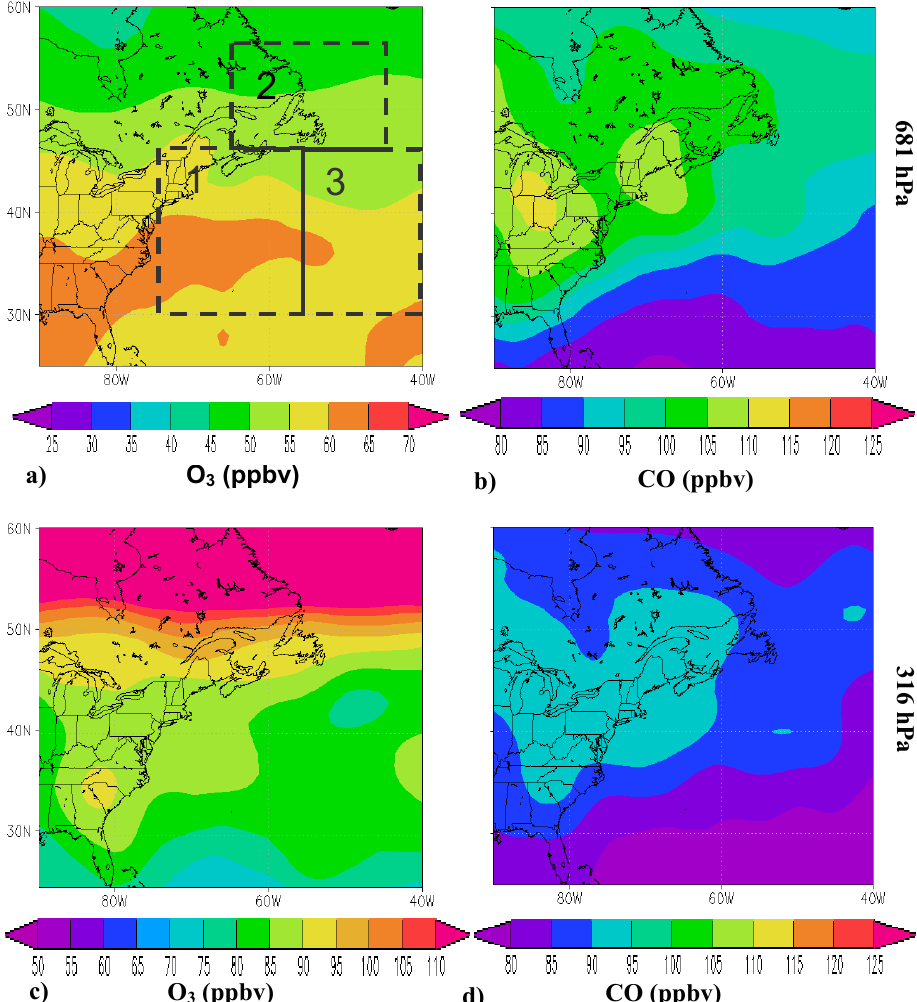
Fig. 3. The JJA seasonal composites for (a) 681hPa O 3 (ppbv) (b) 681hPa CO (ppbv), (c) 316hPa O 3 (ppbv) and (d) 316hPa CO (ppbv). Regions 1, 2, and 3 are marked as dashed black lines on